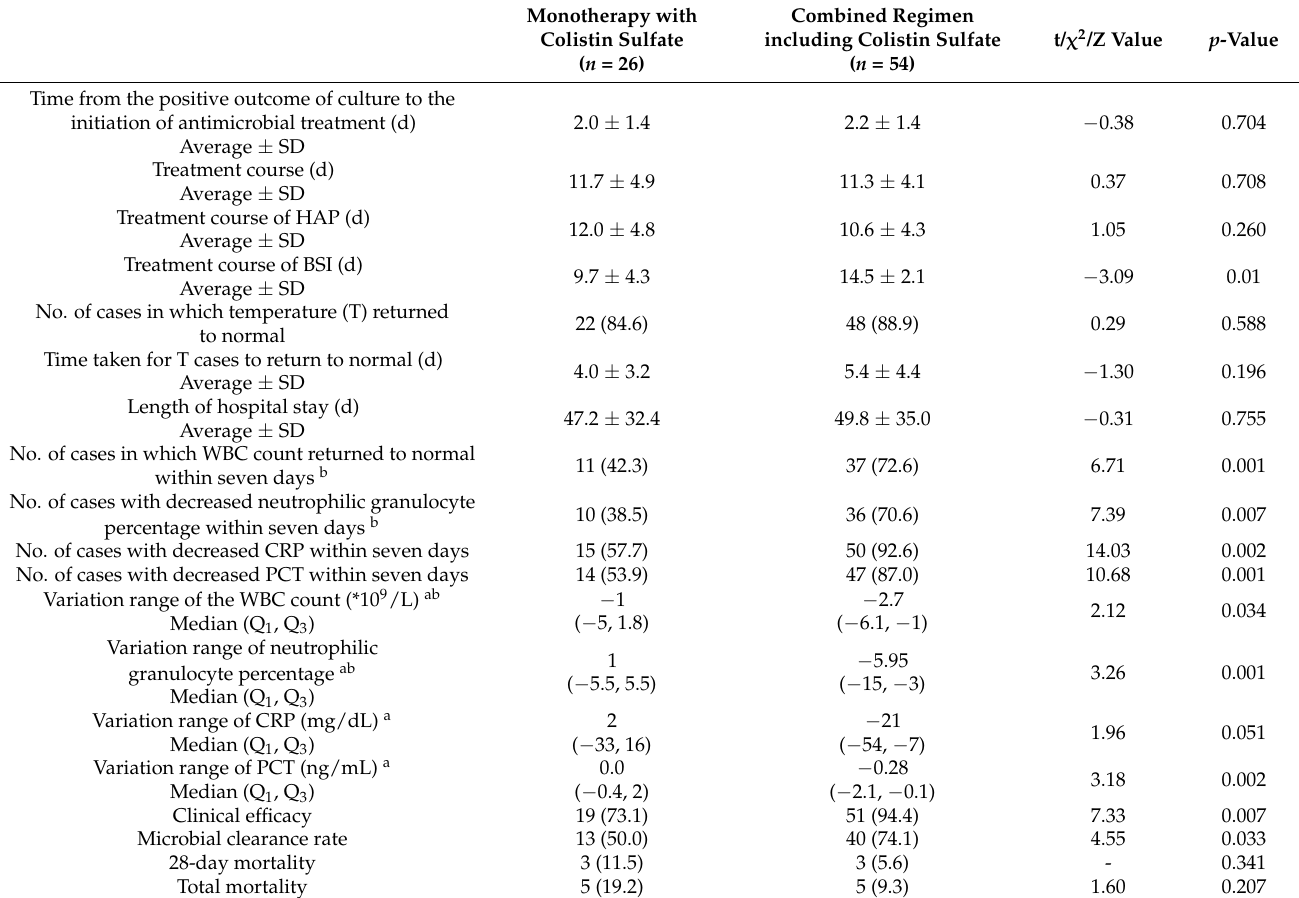
Table 3. Clinical efficacy assessment of the monotherapy and combination therapy groups. Monotherapy with Combined Regimen Colistin Sulfate including Colistin Sulfate t/ χ 2 /Z Value p ( n = 26) ( n = 54)